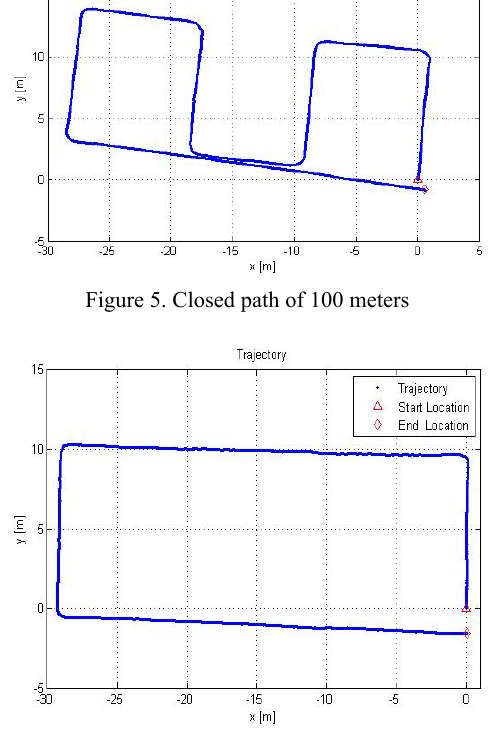
Figure 6. Closed path of 80 meters